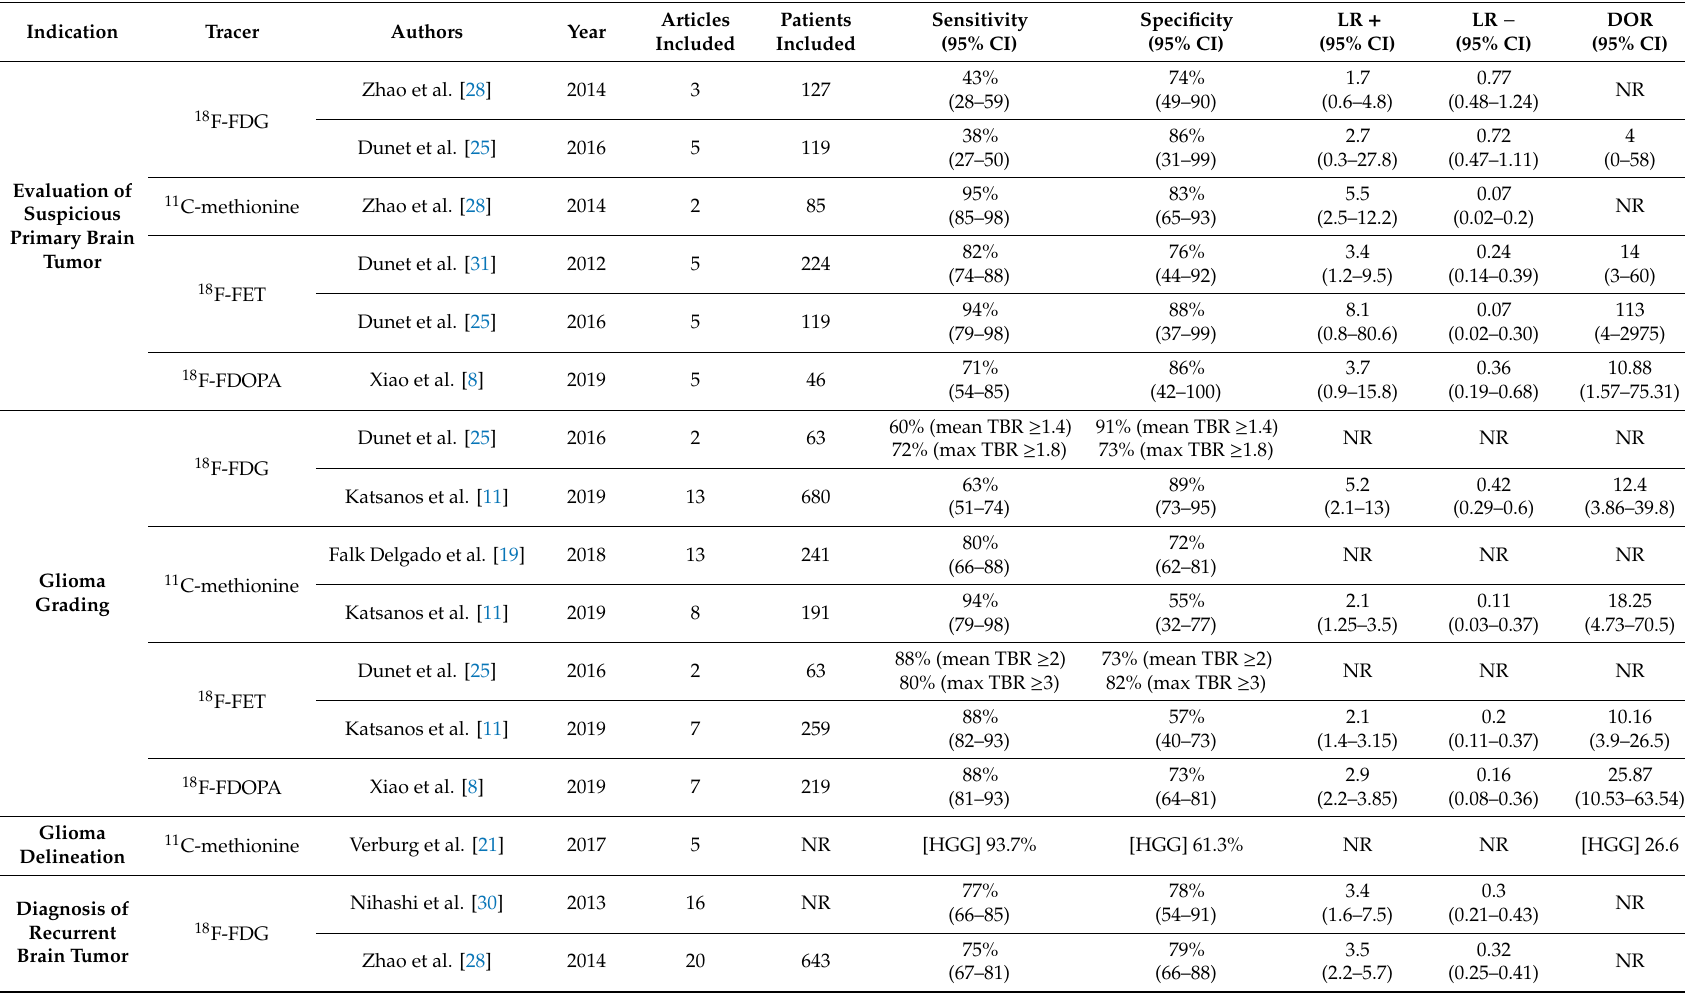
Table 1. Characteristics and main findings of included meta-analyses on the diagnostic performance of PET or PET / computed tomography (CT) with di ff erent tracers in patients with brain